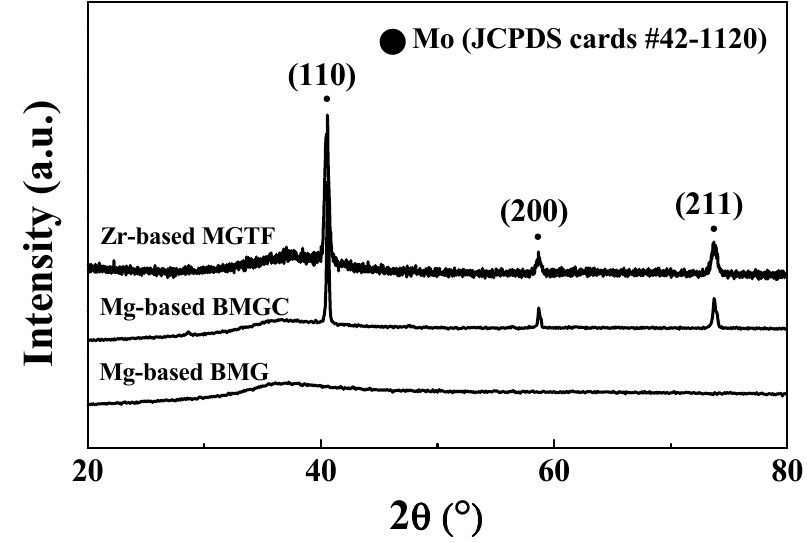
Figure 4. X-ray diffraction patterns of Mg-based BMG, Mg-based BMGC, and Mg-based BMGC coated with Zr-based MGTF. Table 2. Chemical composition of Zr-based MGTF coating analyzed by EDS.